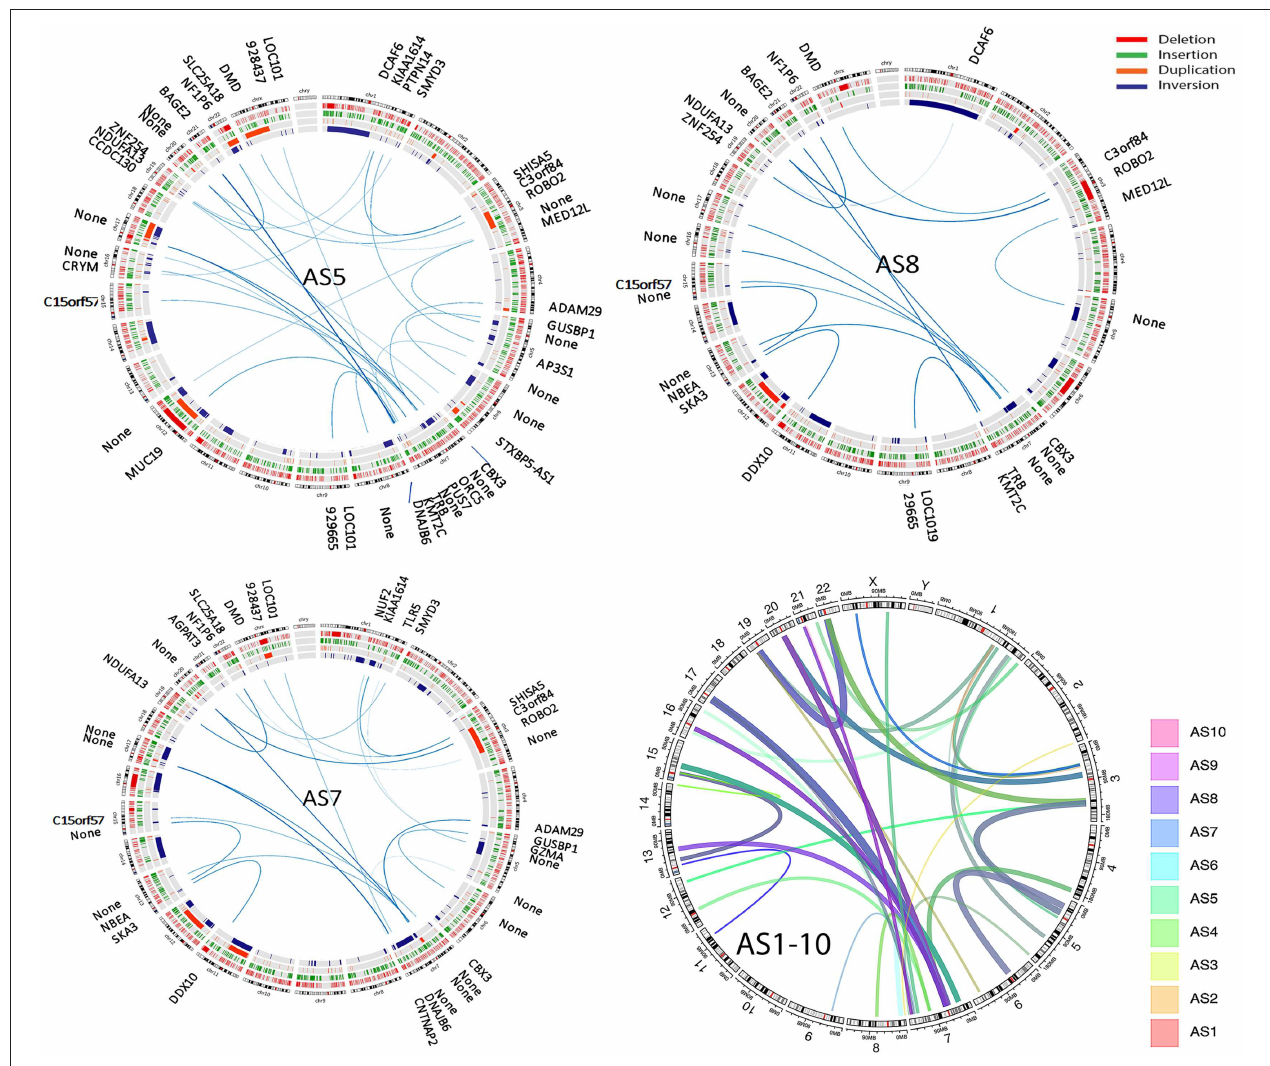
FIGURE 3 | Structure variation (SV) analysis of genomic rearrangements in different chromosomes illustrated by Circos plots. Circos plots of the selected three Müllerian adenosarcomas (AS5, AS8, and AS10) show SVs including deletion (red), insertion (green), duplication (orange), and inversion (blue) detected by next-generation sequencing (NGS) analysis. The lines traversing the ring indicate the genes (denoted outside of the circus plot) or non-gene genomic regions (thickness indicates the relative rate by NGS reads) indicating the in-frame gene or genomic fusion/rearrangement. The final circos plot (right lower) provides a summary of total SV changes from all 10 MAS, with each MAS indicated by the color legend on right of the